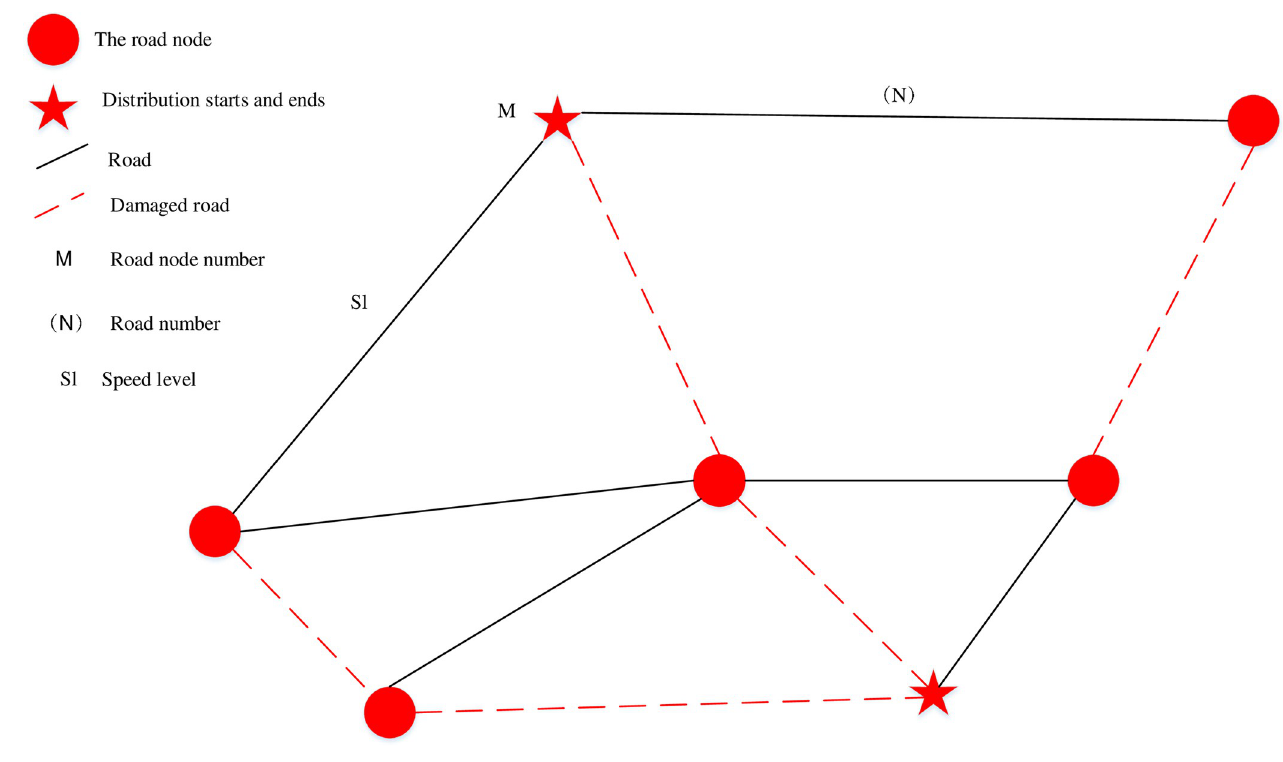
Fig 1. Distribution